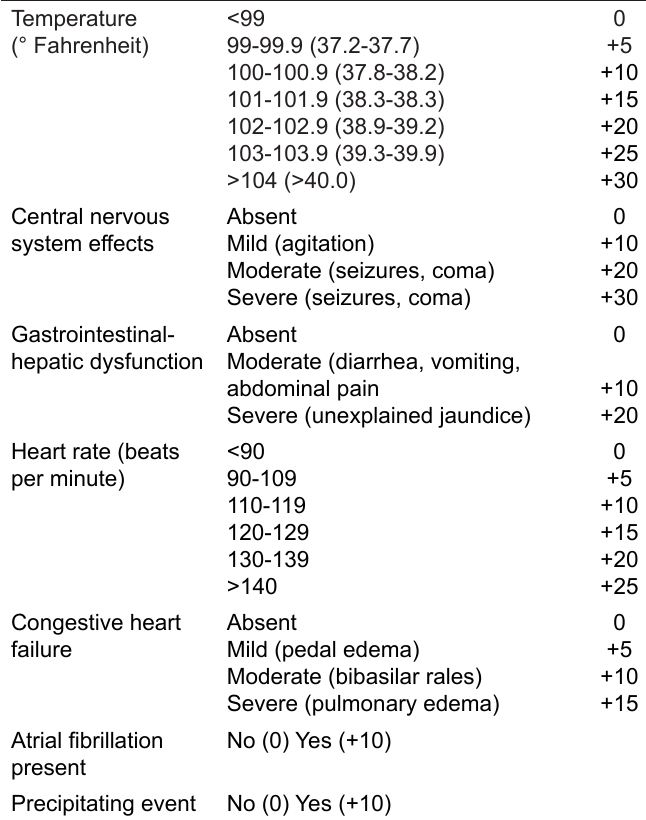
Table 3. The Burch-Wartofsky point scale. 7